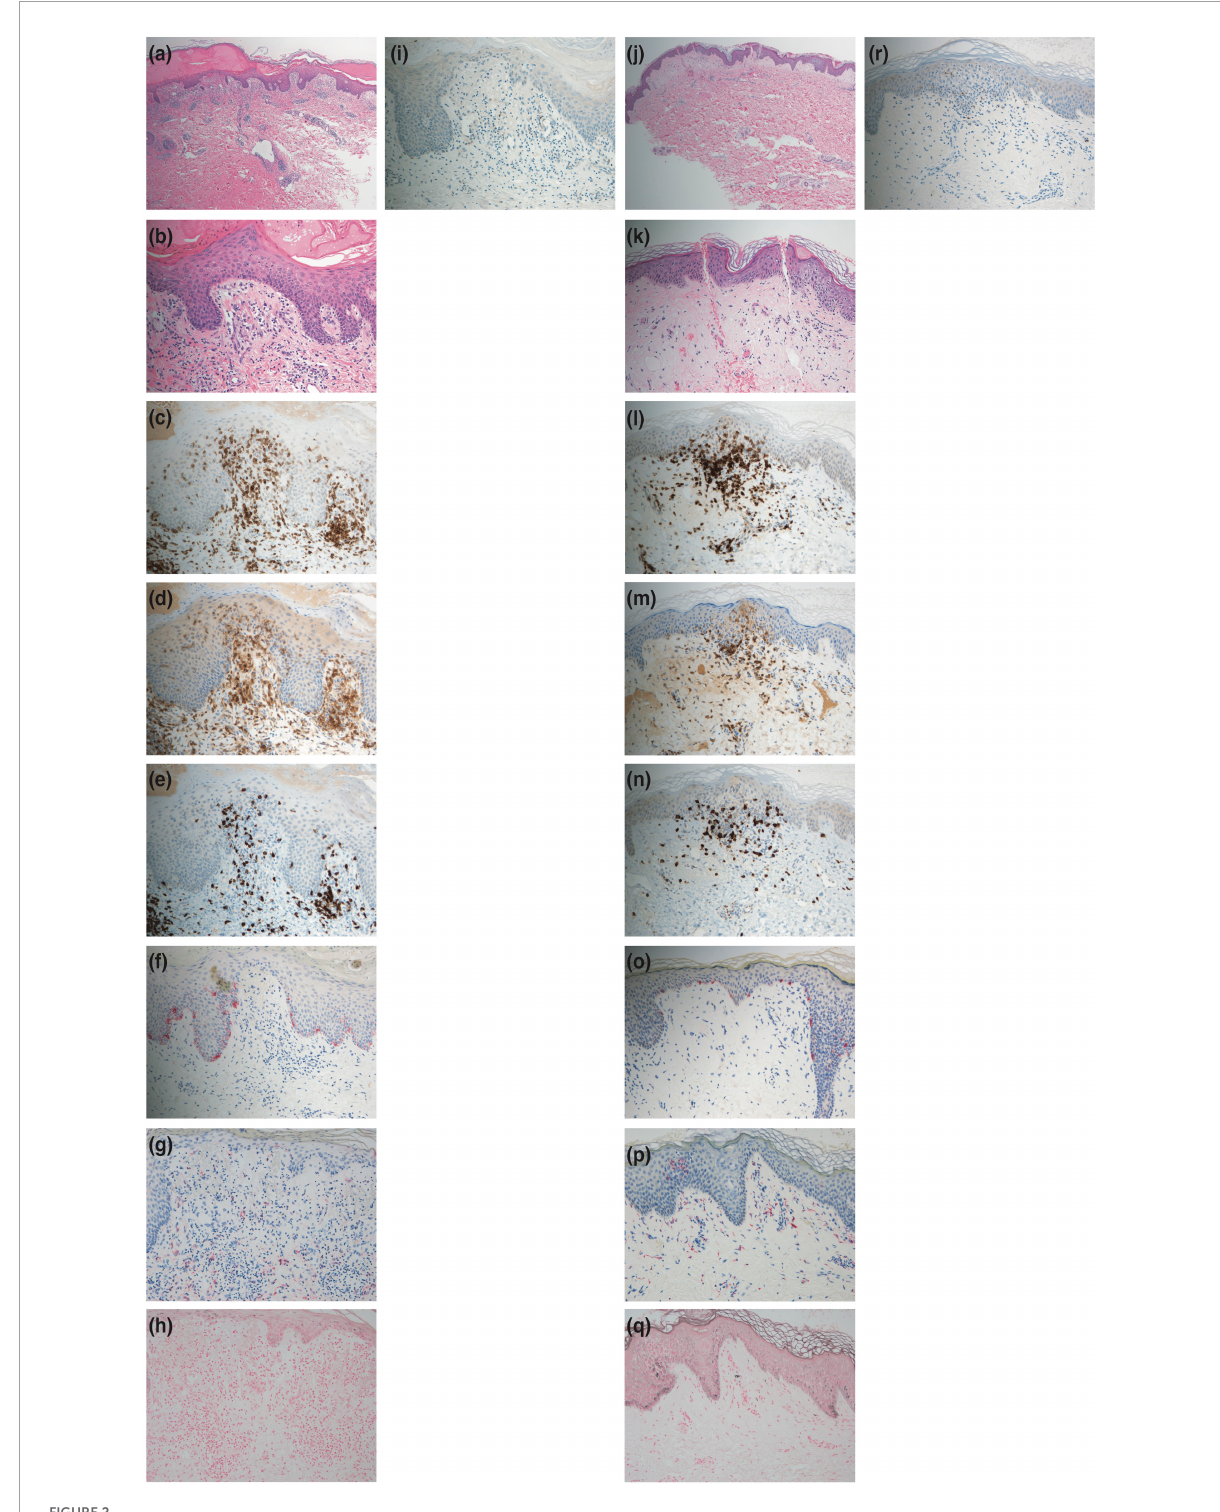
FIGURE2 Histopathological features. (a,b) Hematoxylin-eosin staining of a skin biopsy specimen from the right knee at the first consultation showing minimal liquefaction degeneration in the basal layer of the epidermis. Also, lymphocytes and eosinophils are observed around the blood vessels of the dermis [panel (a) × 40, panel (b) × 200]. (c) CD3 staining showing positive results in the cell infiltrations ( × 200). (d) CD4 staining showing positive results in the cell infiltrations ( × 200). (e) CD8 staining showing positive results in the cell infiltrations ( × 200). (f) Melan-A staining showing positive results in melanocytes ( × 200). (g) Few melanophages in the dermis with CD68-positive staining ( ×